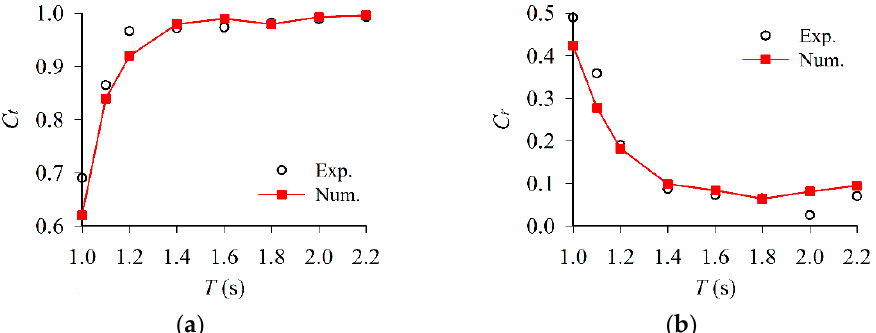
Figure 9. Comparison of the experimental and numerical wave transmission coefficients and re- flection coefficients of the dual cylindrical floating pontoon: ( a ) Wave transmission coefficient C t ; ( b ) Wave reflection coefficient C r . ( b ) Wave reflection coefficient C r